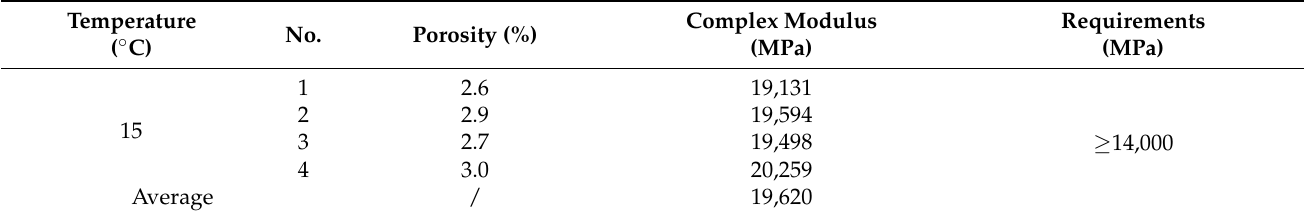
Table 11. Results of the dynamic modulus